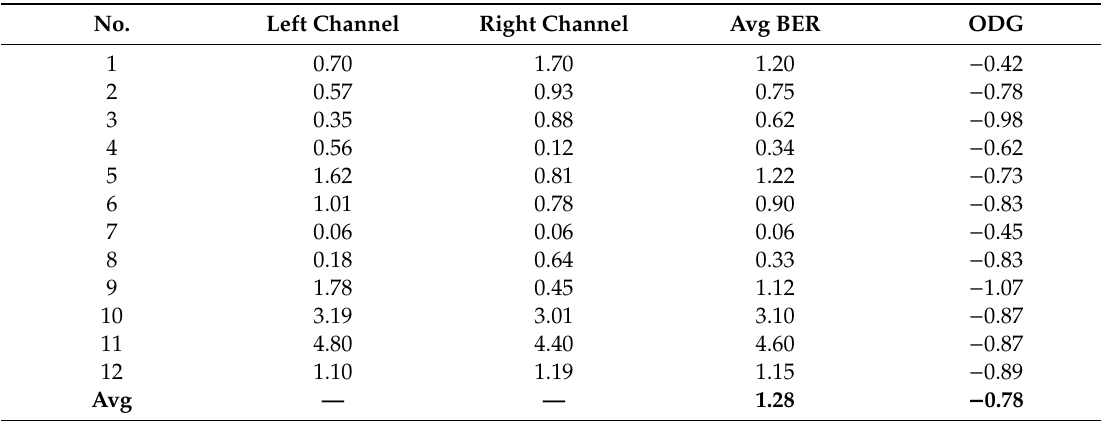
Table 9. BER (%) and ODG of each channel of stereo audio under HE-AAC v2 48 kbps compression.